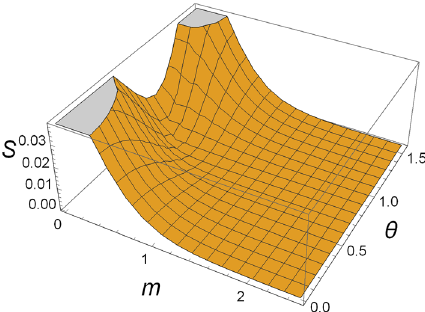
Fig. 3 A three dimensional plot depicting the variation of the entan- glement entropy with θ RL and the mass m in an equal footing